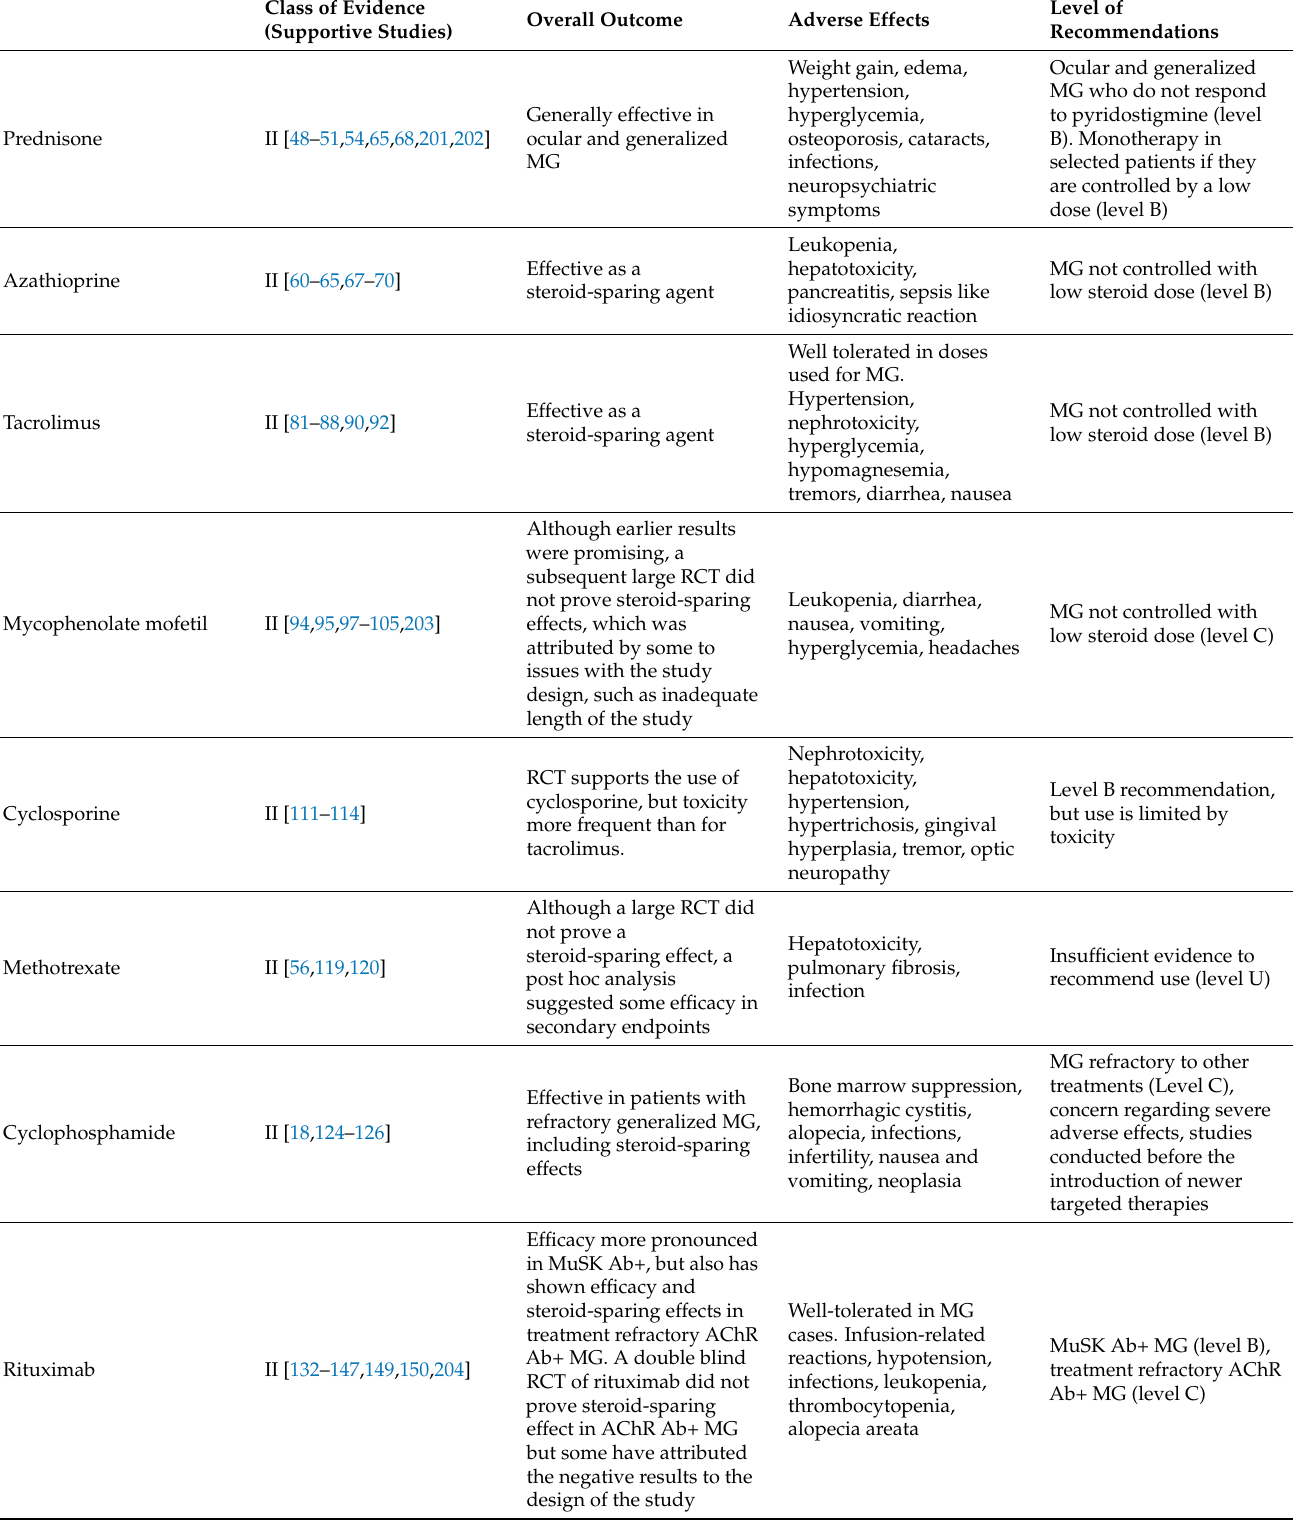
Table 1. The class of evidence, overall efficacy, common and more significant side effects of im- munomodulatory treatment options in